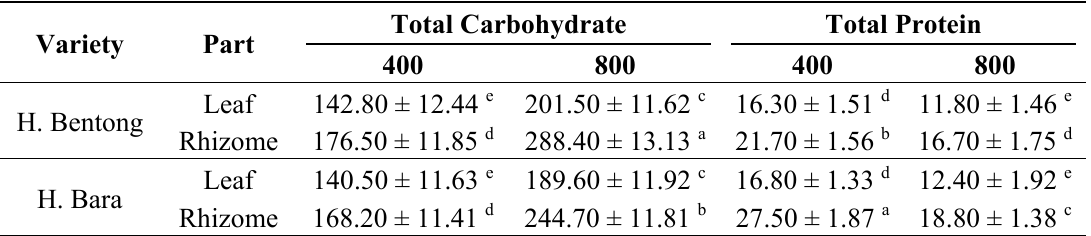
Table 1. Total carbohydrates and protein content in two variety of ginger grown under different CO 2 concentration (400 and 800 μ